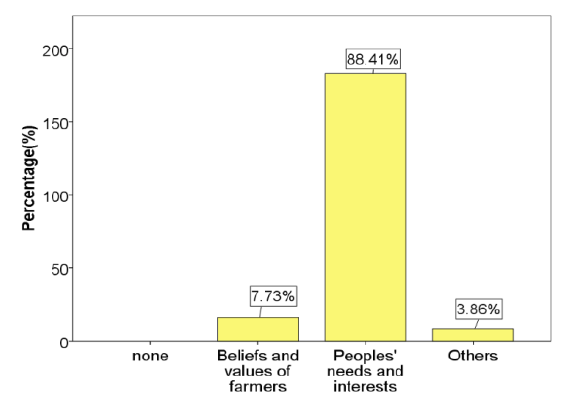
Figure 3: Features that Extension Service Providers take into